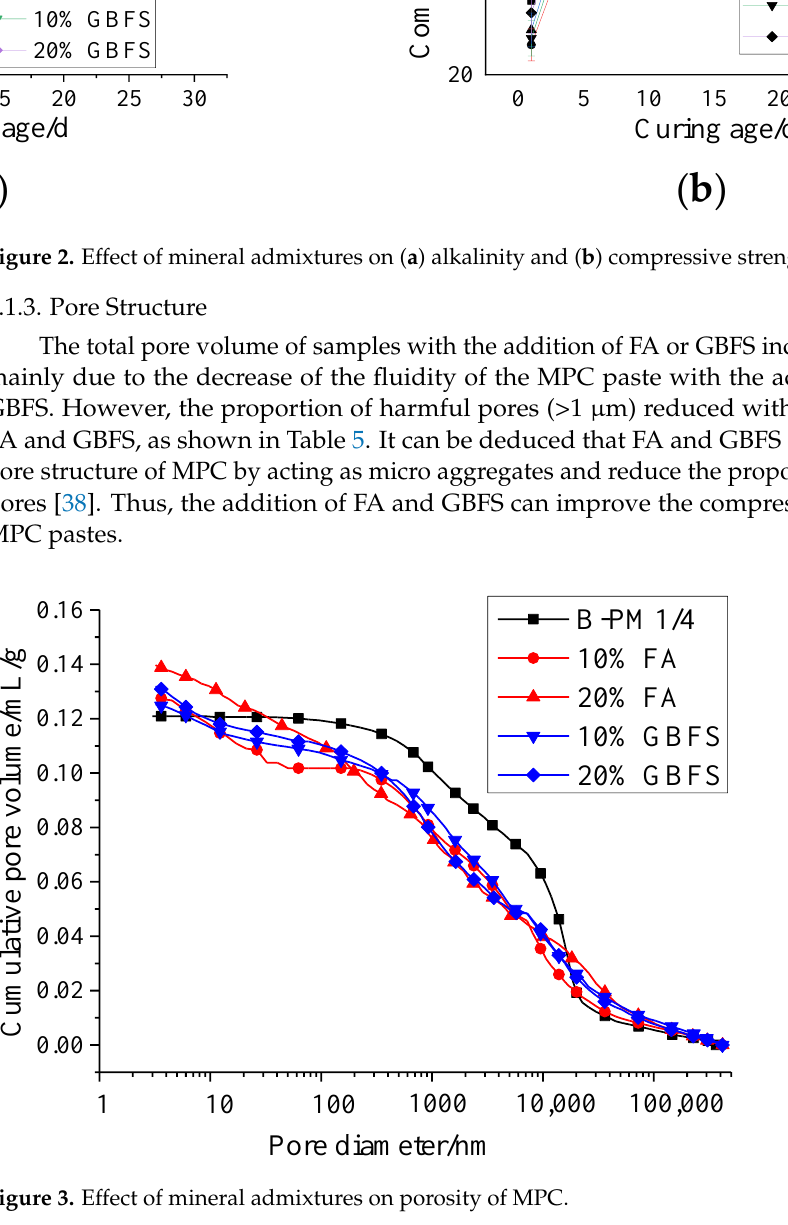
Sample • Figure 4. MPC components analysis of different P/M. It can be seen from Figure 5 that the main crystalline phases in FA are mullite (3Al 2 O 3 ·2SiO 2 ) and quartz (SiO 2 ), and the main crystalline phase in GBFS is akermanite (Ca 2 (Al, Mg)[(Si, Al)SiO 7 ]). With the addition of FA, the main components of MPC/FA are